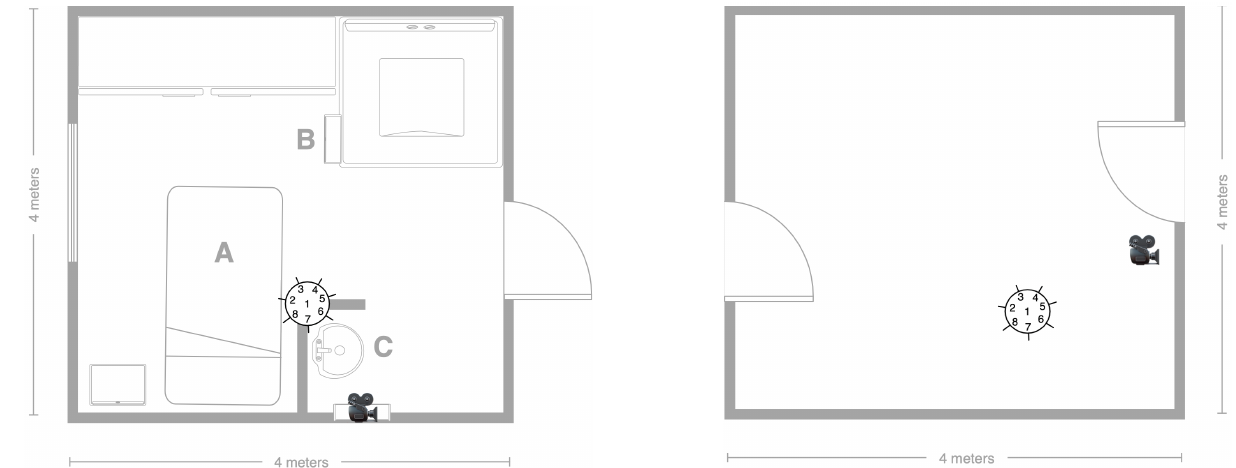
Figure 8. Sketches of the bedroom and the empty room that mimics a corridor for a free walk.